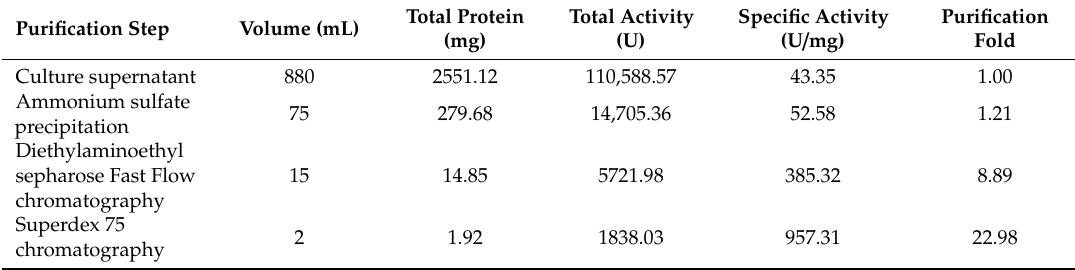
Table 1. Summary of purification for CelA J93.